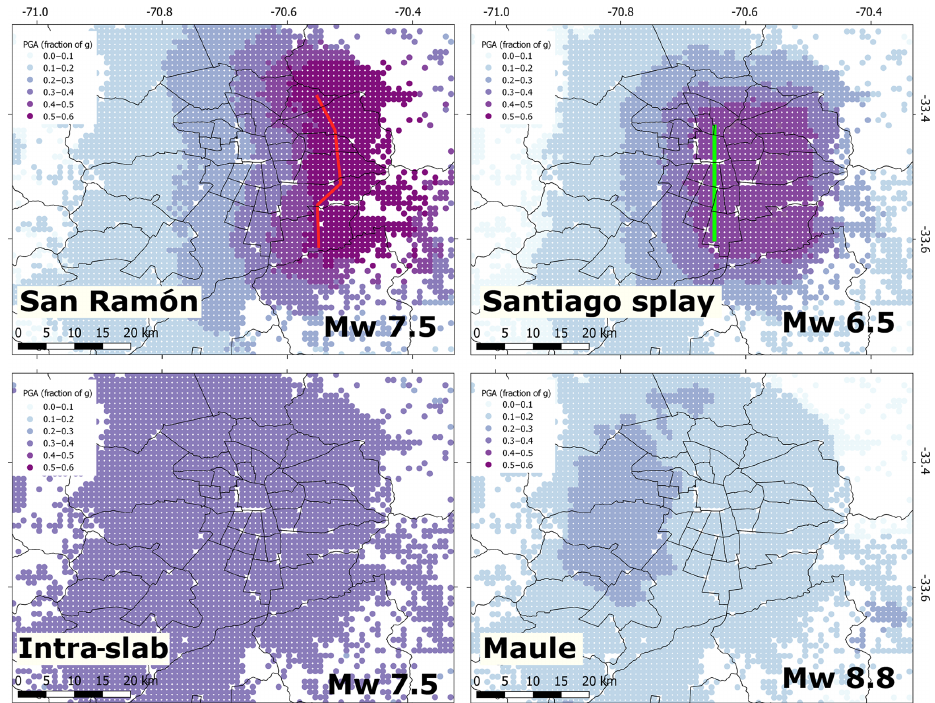
Figure 9. The estimated median peak ground acceleration (PGA) as a fraction of gravity g for the largest earthquake scenario considered for each fault. For the San Ramón (red line) and Santiago splay fault (green line) cases, these estimates were obtained using the Akkar et al. (2014) ground motion prediction equation, while those for the intra-slab fault are estimates from the Abrahamson et al. (2016) equation. The USGS peak ground accelerations for the M w 8.8 Maule earthquake are shown at the bottom. The ground motions for the full set of earthquake scenarios are given in Fig. S4. Table 2. Exposed populations and buildings for the 10 most affected communes in terms of average modelled building collapse across the six earthquake scenarios (full list in Supplement; Tables S2 and S3). The communes are ranked in order of average collapse count. Communes Area Population Pop n density Pop n below Buildings in exposure model (% of total) km 2 (per km 2 ) poverty line ∗ (%) RC MCF MR MUR W Total